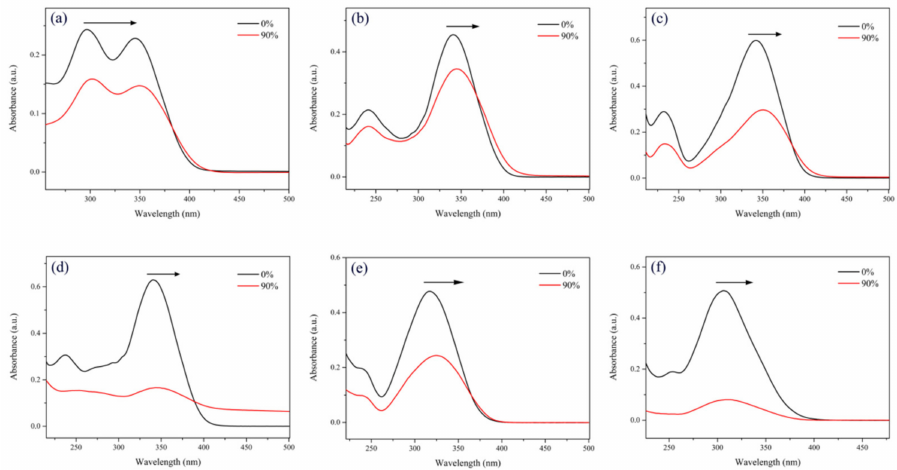
Figure 3. UV–vis absorption spectra of compounds ( a ) 1 , ( b ) 2 , ( c ) 3 , ( d ) 4 , ( e ) 5 , and ( f ) 6 in pure CH 3 OH solution and CH 3 OH/H 2 O mixed solution with 90% water contents.